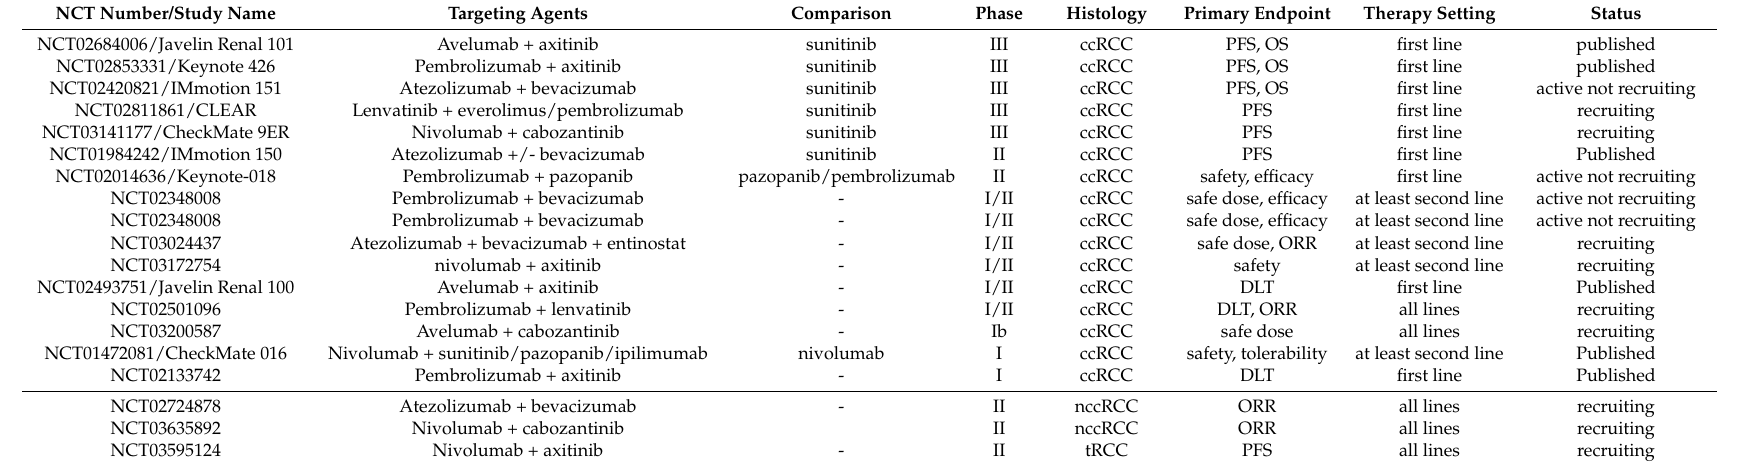
Table 4. Clinical trials evaluating immune checkpoint inhibitors in association with antiangiogenic drugs